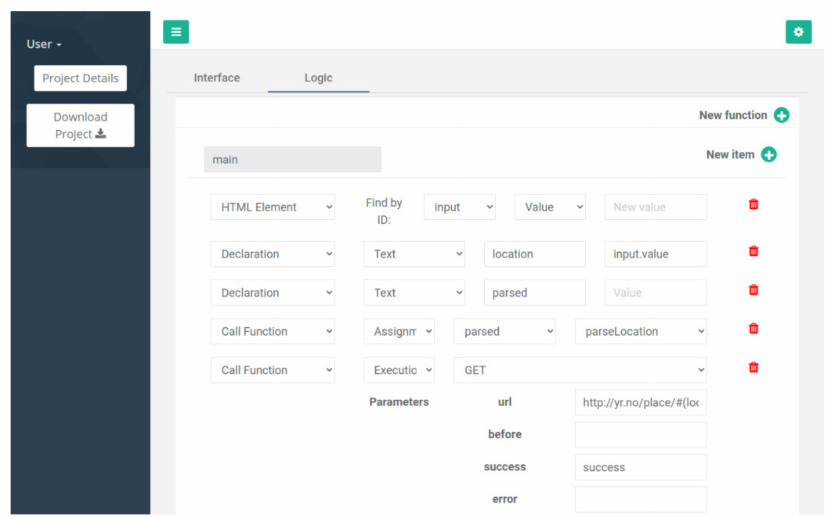
Figure 4. Logic screen for an application that pulls the temperature from a Website and displays its value on a canvas.